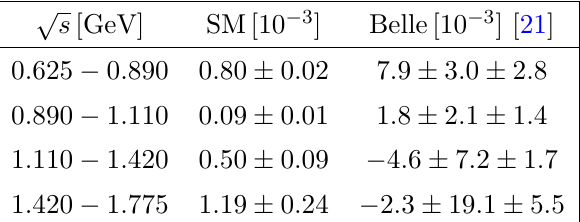
Table 2 . Our predictions within the SM as well as the Belle measurements for the CP -violating angular observable A CP ( t 1 ; t 2 ) in four di(cid:11)erent mass i